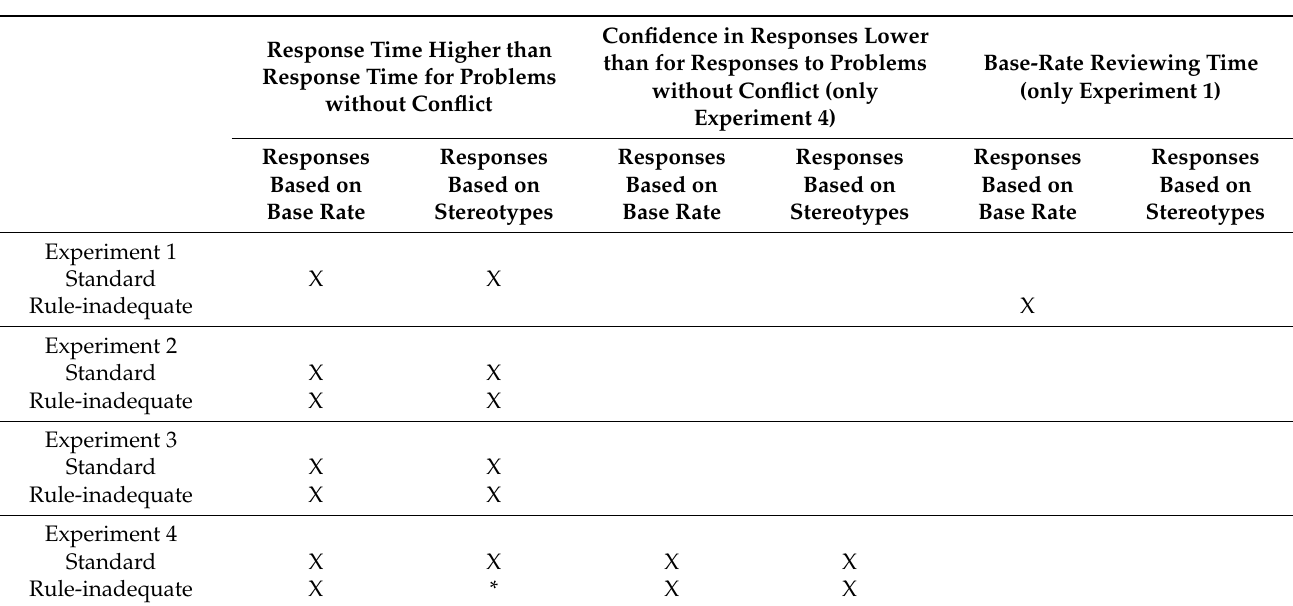
Table 2. Evidence of conflict detection for standard and rule-inadequate problems (Experiments 1 to 4).